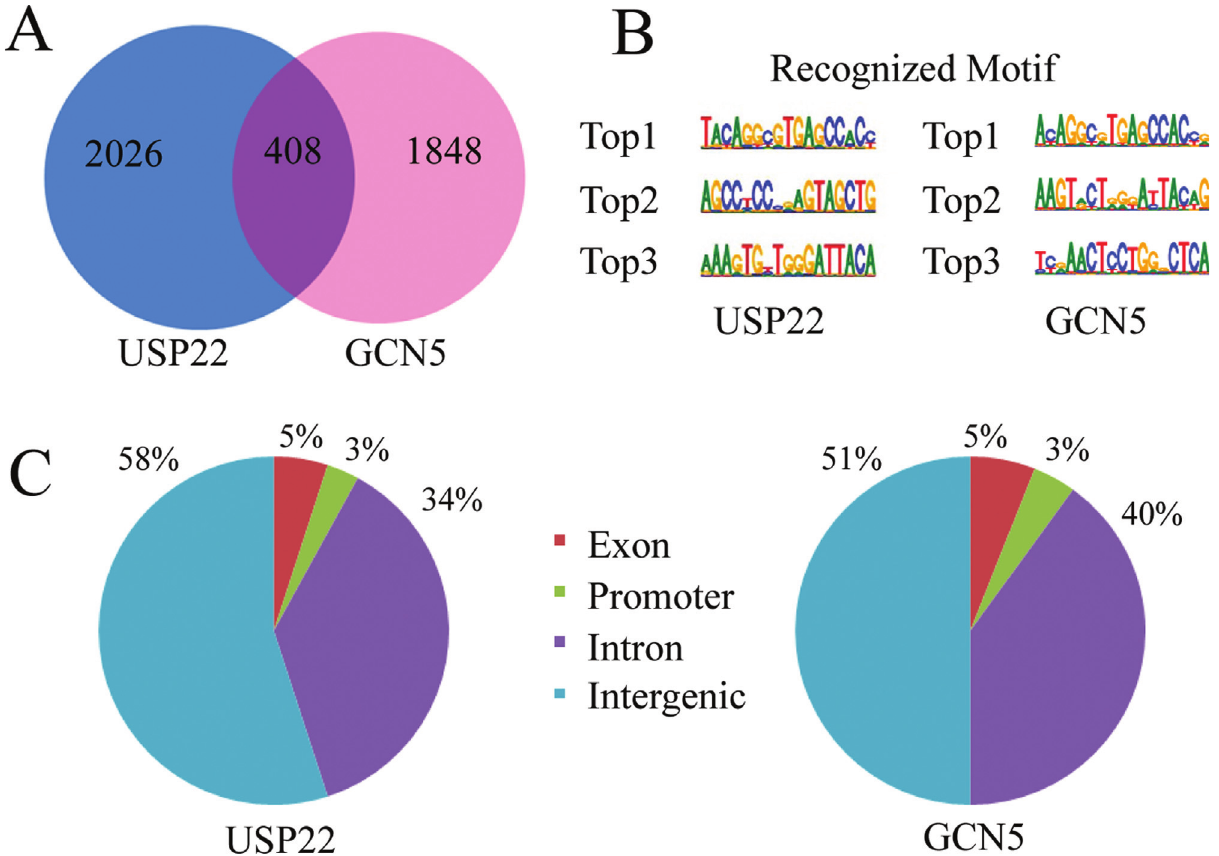
Figure1 -CharacterizationofUSP22andGCN5bindingsitesinhumangenome.(A)TotalnumberofgeneswithUSP22andGCN5occupancyintwoin- dependent ChIP samples. There were 408 gene targets bound by both USP22 and GCN5. ( B) Motif analysis of USP22 or GCN5-bound genomic regions showing the top 3 enriched new sequence motifs. (C) Pie charts show the distribution of USP22 or GCN5 binding sites in the